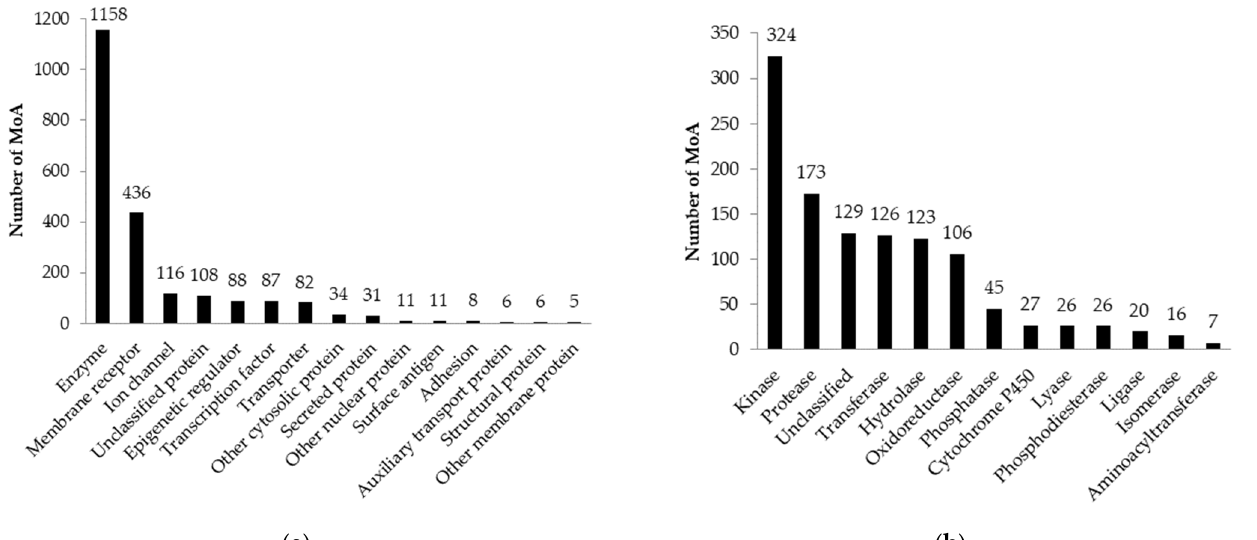
Figure 3. Distribution of predicted mechanisms of action by protein families: ( a ) number of predicted MoA classifying by ChEMBL protein family level 1; ( b ) number of predicted MoA classified by ChEMBL protein family level 2 for the enzyme protein family.